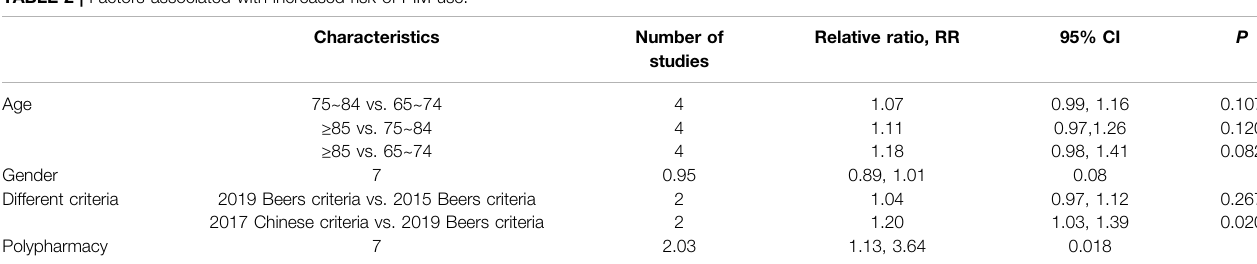
TABLE 2 | Factors associated with increased risk of PIM